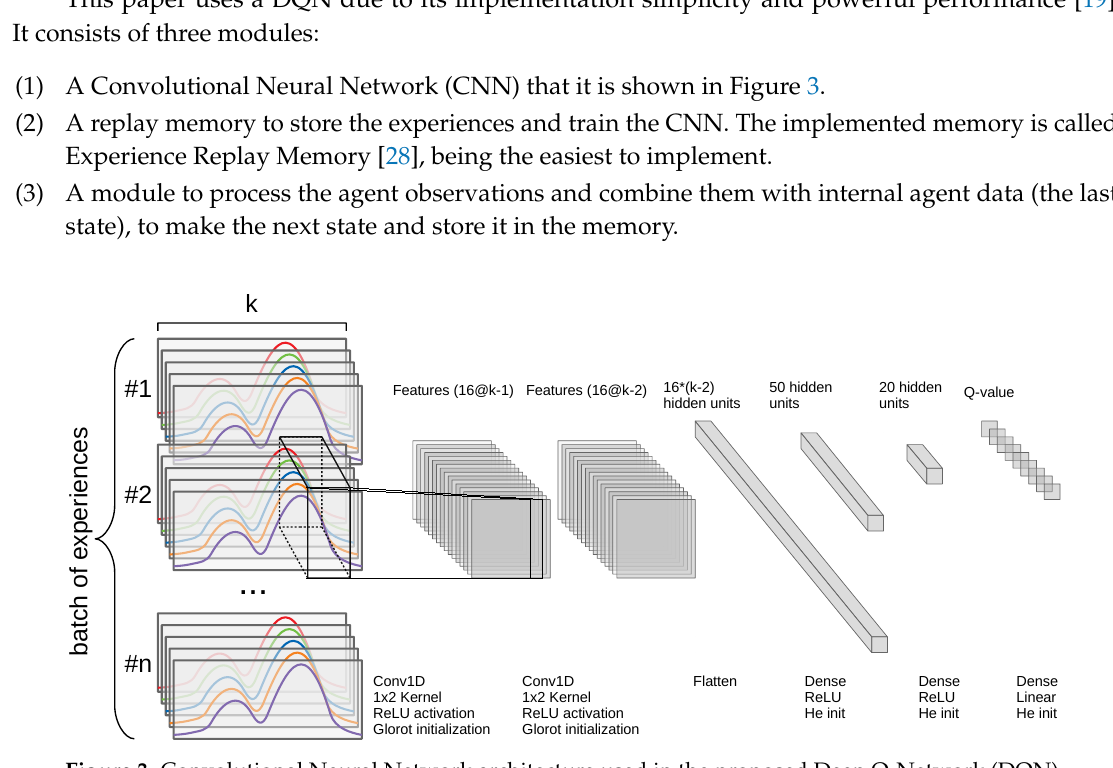
Figure 3. Convolutional Neural Network architecture used in the proposed Deep Q-Network (DQN).